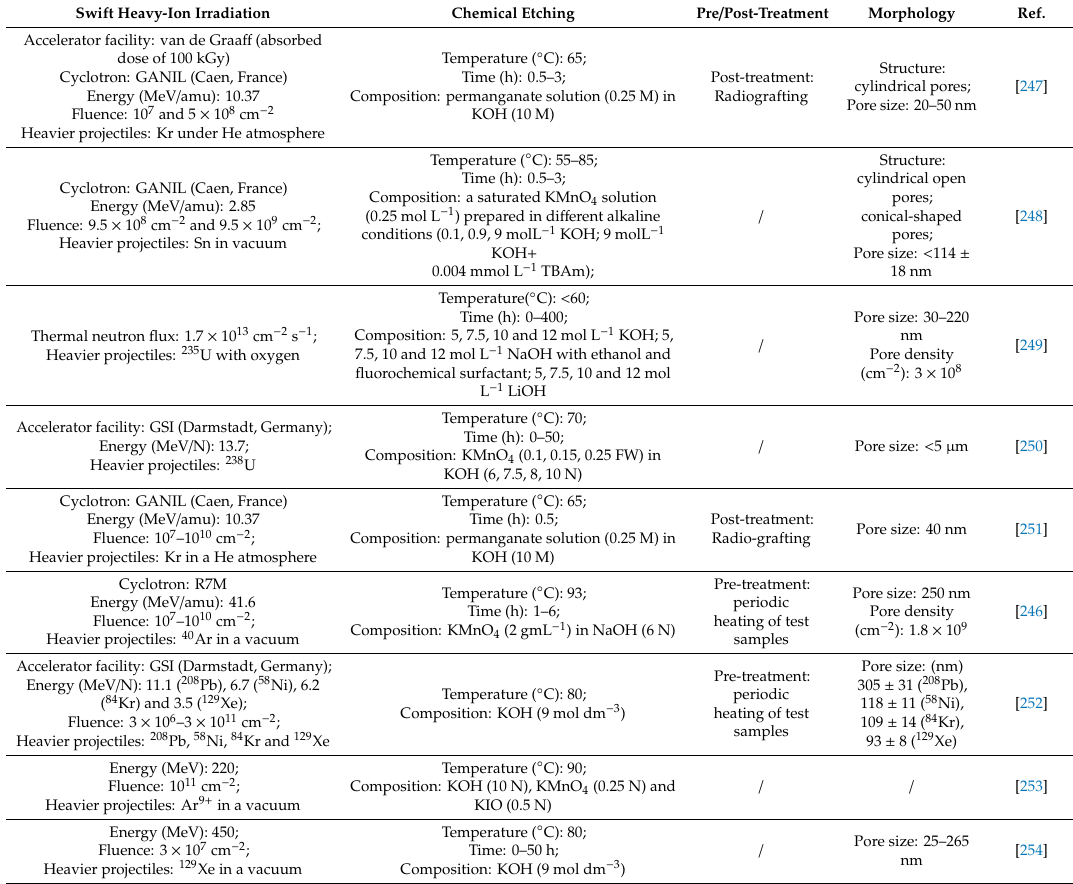
TBAm = Tetrabutylammonium bromide; KOH = potassium hydroxide; NaOH = sodium hydroxide; LiOH = lithium hydroxide; KMnO 4 = potassium